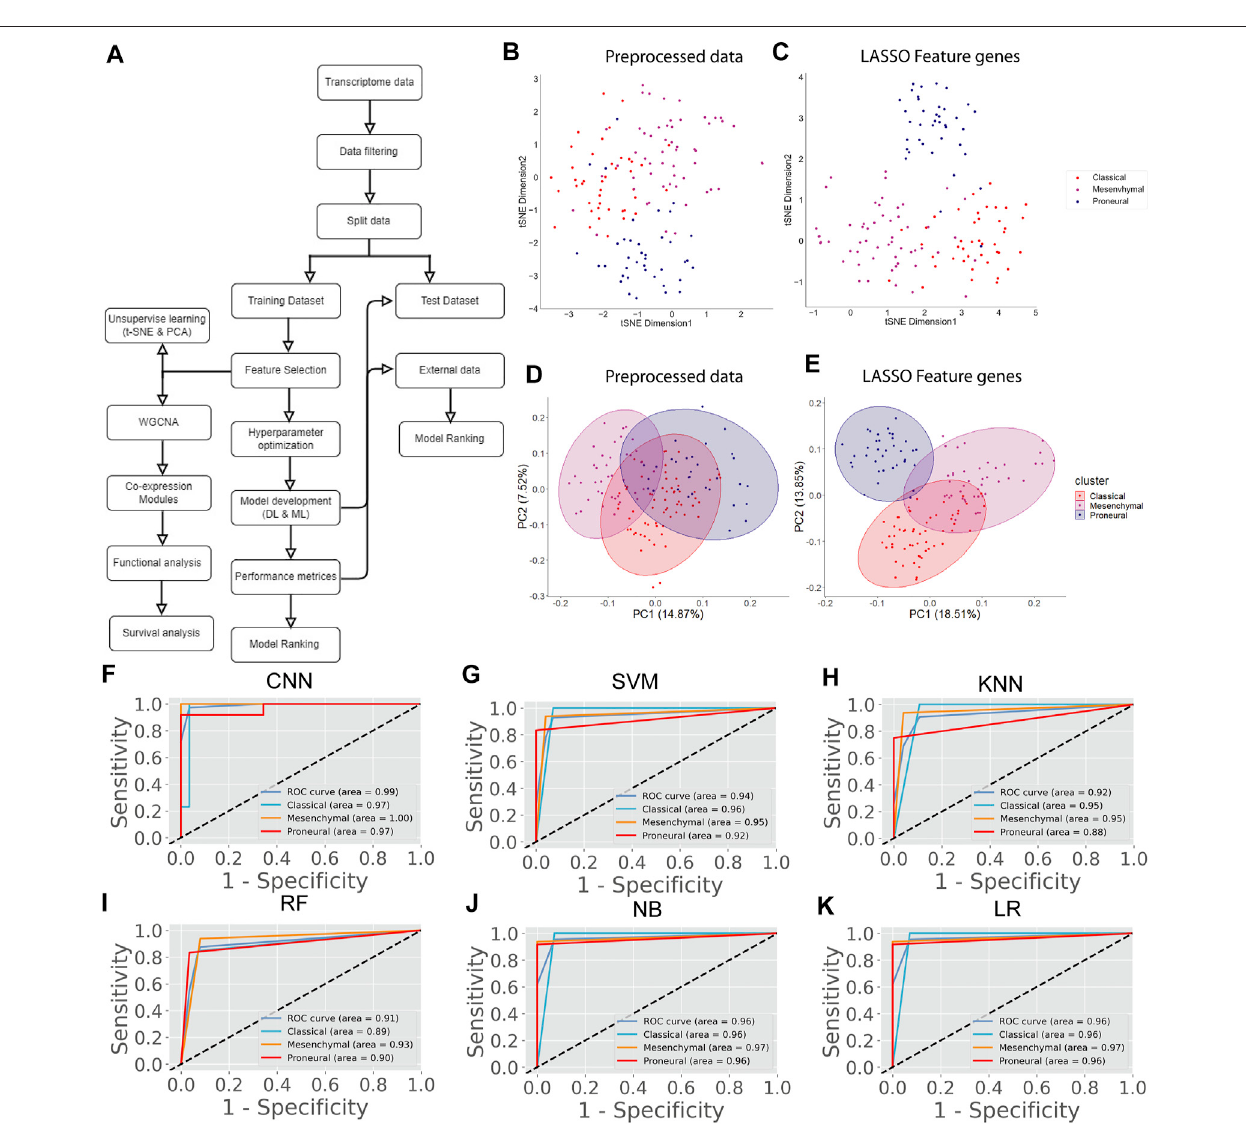
FIGURE1| GBMsubtypeclassi fi cationusingtranscriptomedata. (A) The fl owchartshowsDLandMLpipelinesusinggenome-widetranscriptomedatatoclassify thesubtypes. (B,C) t-SNEplotstovisualizethesubtype-speci fi cclusteringofthepatientsusingpreprocesseddataandfeaturesgenes. (D,E) PCAplotstovisualizethe subtype-speci fi c clustering of patients using preprocessed data and feature genes. (F – K) ROC of various prediction models. ROC plots were generated using a test data set.